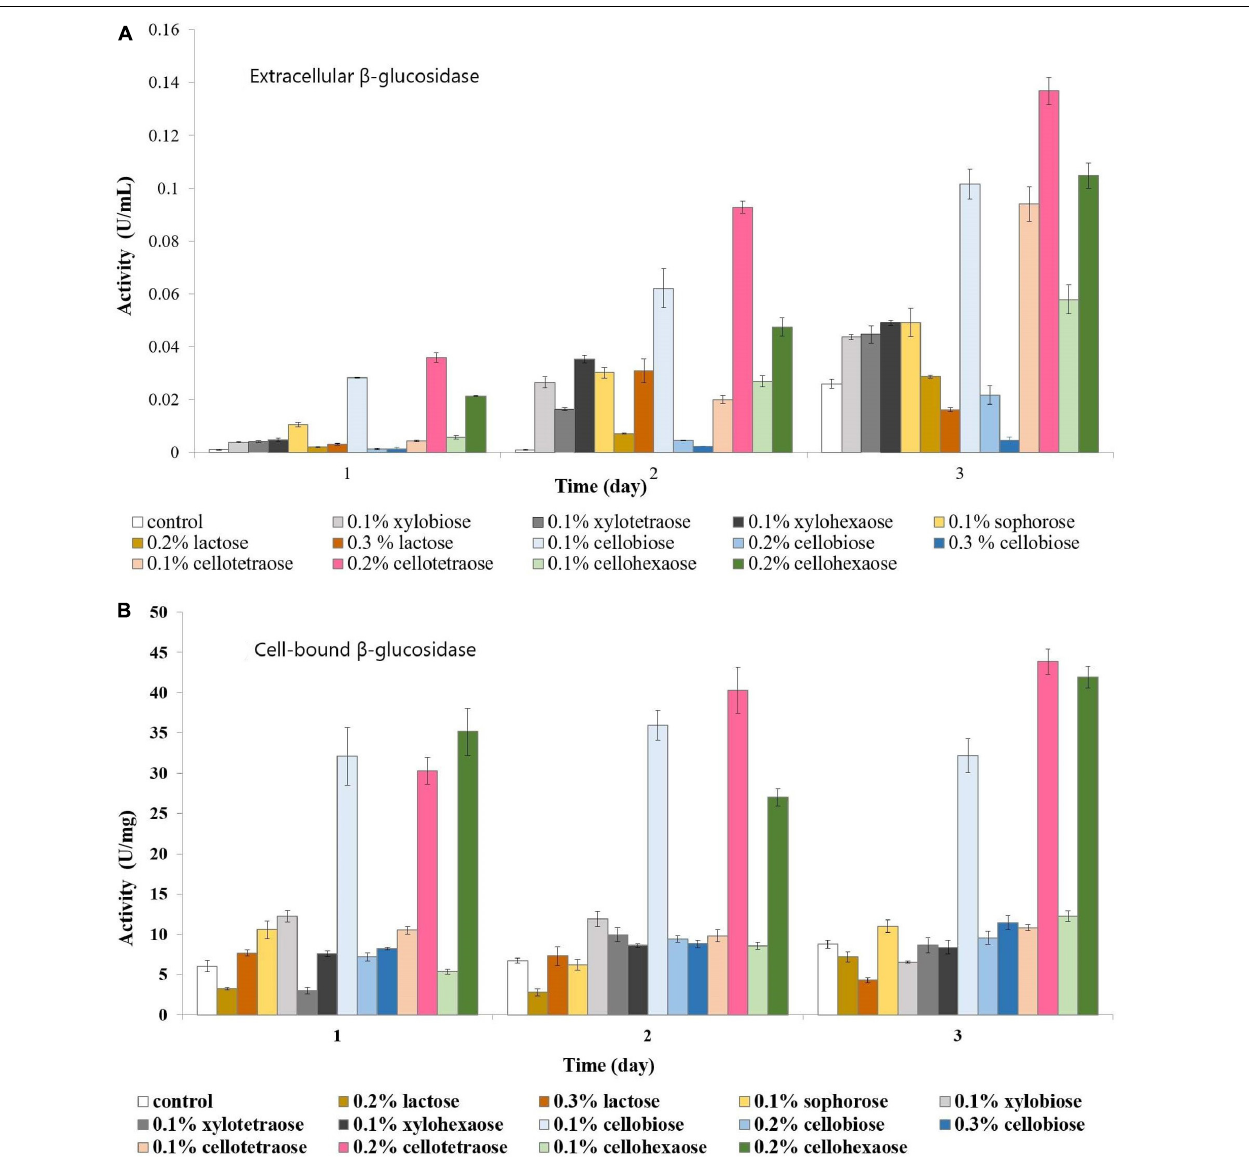
FIGURE 3 | β -glucosidase activity of sucrose-grown biomass in the presence of different inducers and using pNPG as substrate. (A) Extracellular β -glucosidase activity; (B) Cell-bound β -glucosidase activity.